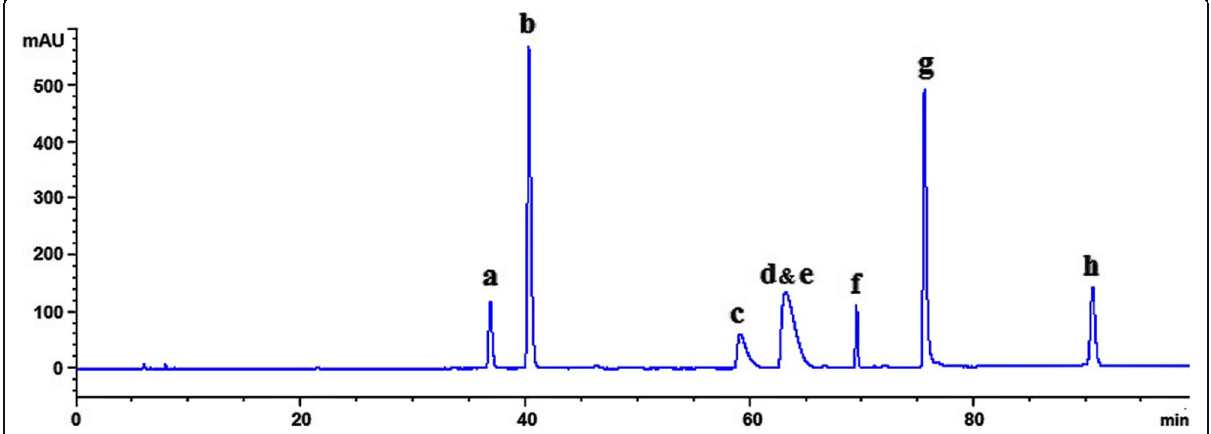
Fig. 1 The chromatograms of mixed reference solution: ( a ) liquiritin, (b) baicalin, ( c ) palmatine hydrochloride, ( d ) berberine hydrochloride, ( e ) liquiritigenin, ( f ) glycyrrhizic acid, ( g ) baicalein, ( h ) glycyrrhetinic